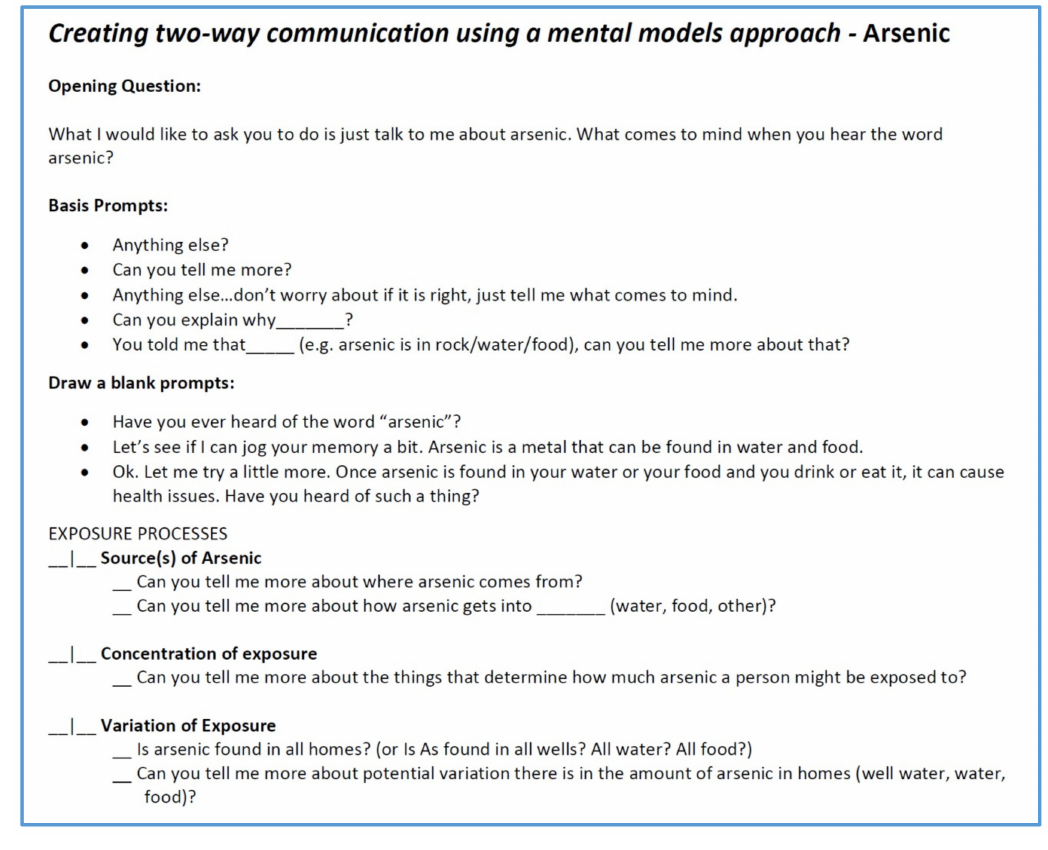
Figure 6. Community interview protocol.